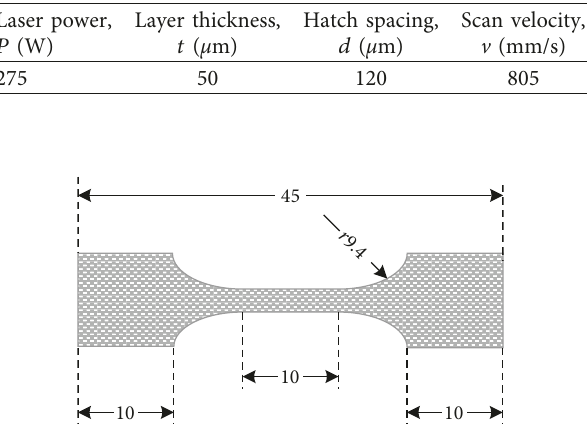
Figure 3: Geometry of the tensile specimen. Dimensions are in mm.